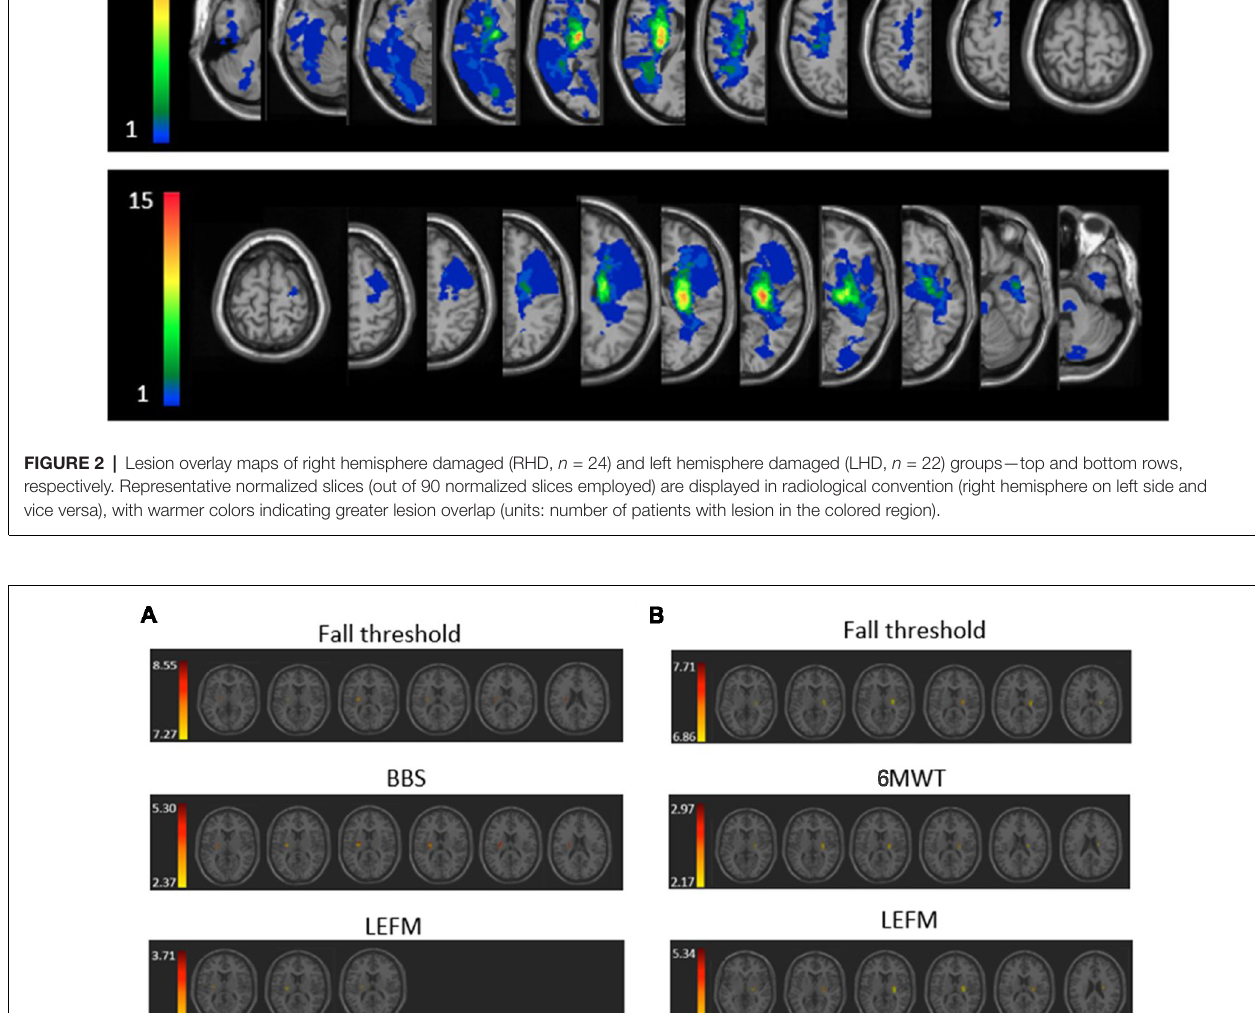
FIGURE 3 | Voxel-based lesion symptom mapping (VLSM) analysis depicting areas where damage was associated with a significant (pFDR < 0.05) impact on (A) fall threshold, Berg Balance Scale (BBS), and Lower Extremity Fugl-Meyer (LEFM) scores in the RHD group, and (B) fall threshold, 6 Minute Walk Test (6MWT) and LEFM scores in the LHD group. Colored regions showed a significant impact on behavioral scores (minimum cluster size: 10 voxels, minimum number of patients: 10). Warmer colors indicate higher z-scores.